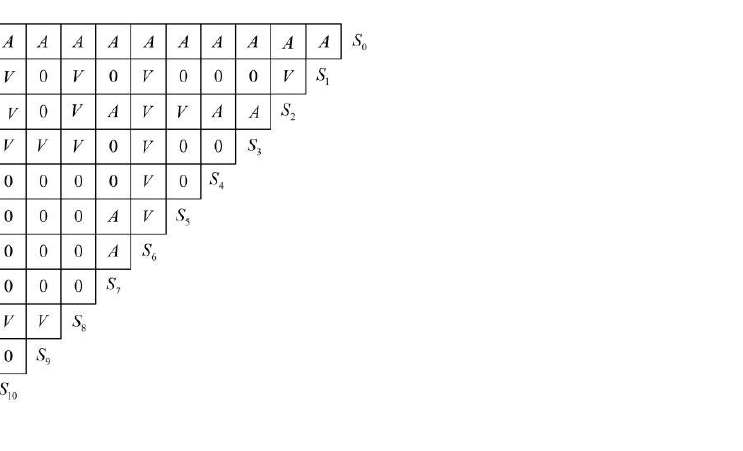
Figure 2. Logical relationship of the factors influencing farmers’ willingness to maintain the